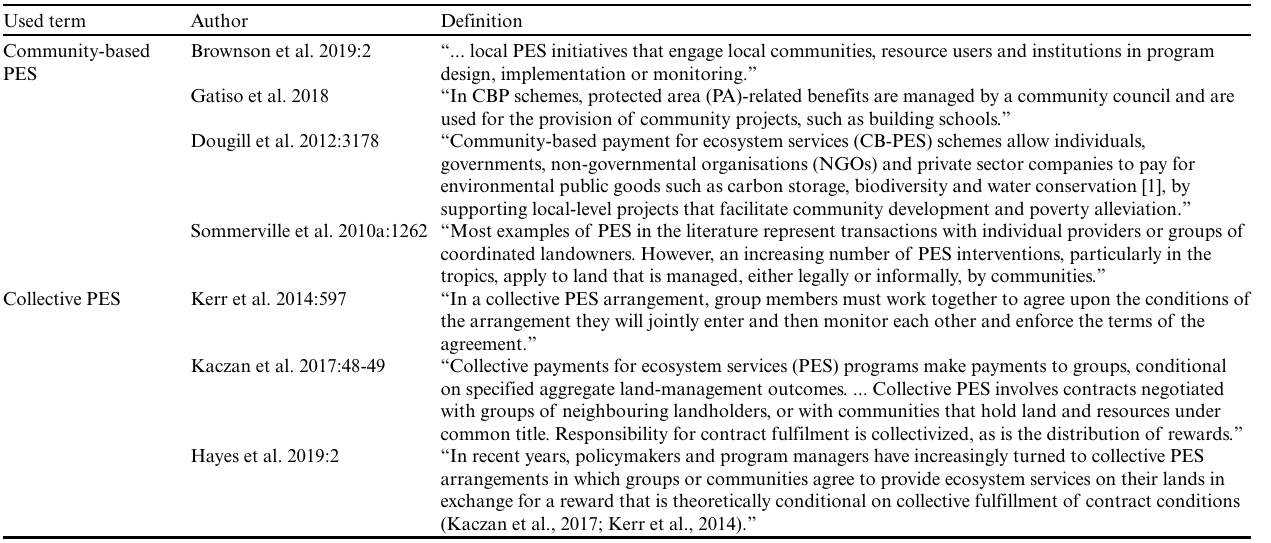
Table 1. Identified definitions for community-based and collective payments for ecosystem services